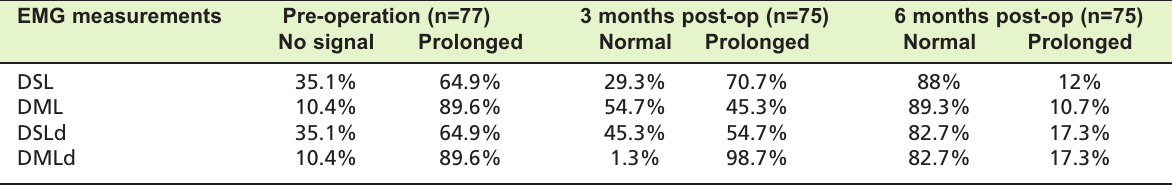
EMG measurements